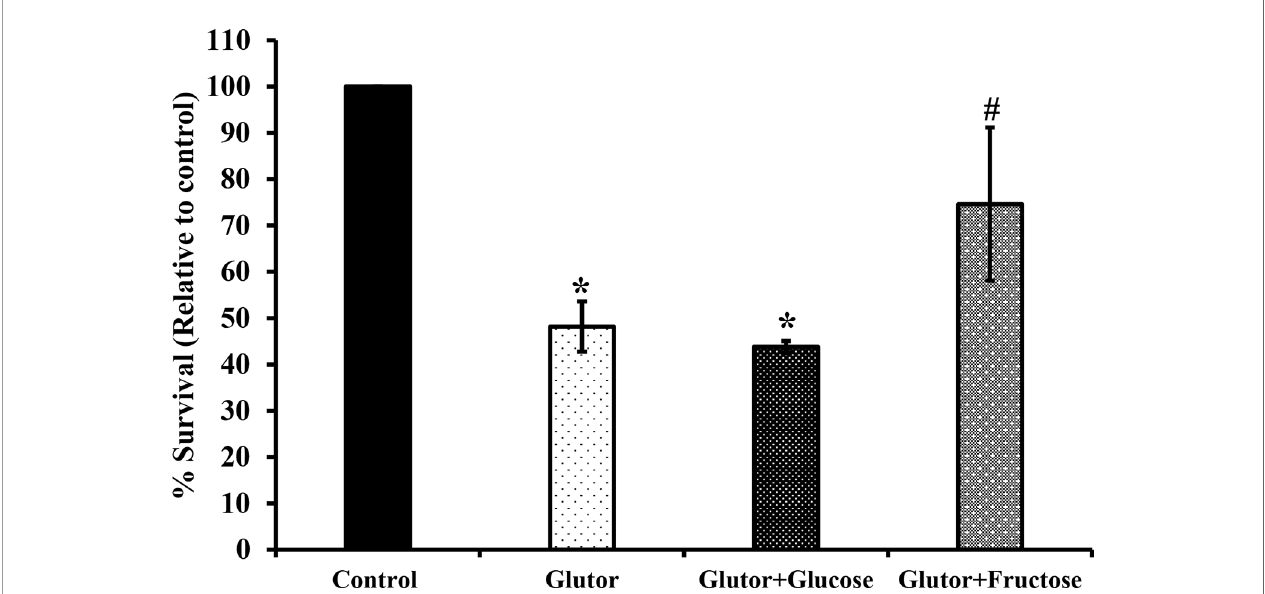
FIGURE 3 | Fructose antagonizes the inhibitory action of glutor on tumor cell survival .DL cells (1 × 10 5 ) were incubated in a medium alone or containing glutor in the presence or absence of glucose (1 mM) or fructose (1 mM) for 24 h, followed by an estimation of survival by MTT assay as described in the Materials and Methods section. Values are mean ± SD. * p < 0.05 vs. DL cells incubated in a medium alone. # p < 0.05 vs. DL cells incubated in a medium containing glutor or glutor plus